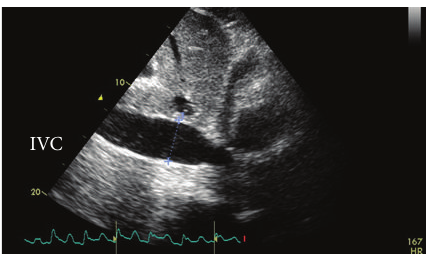
Figure3:Echocardiographicimageshowingnoncollapsibleinferior vena cava with pericardial effusion.